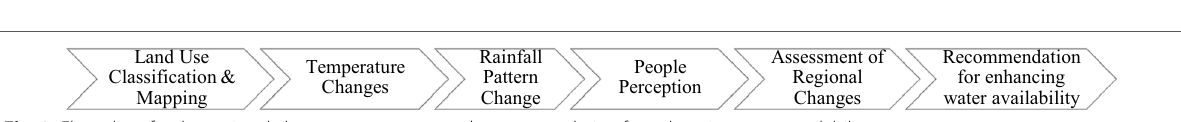
Fig. 2 Flow chart for the regional changes assessment and recommendation for enhancing water